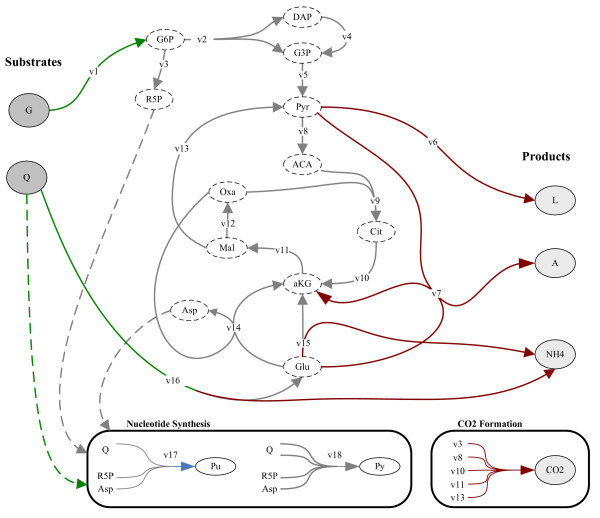
Metabolic Network of CHO cells. Extracted from [41]. Initial substrates (dark grey ovals), extracellular products (light grey ovals), terminal internal metabolites (white ovals) and internal metabolites (white ovals with dashed line). The CO2 formation and the nucleotide synthesis are described separately. The nomenclature is given in the additional file 1.